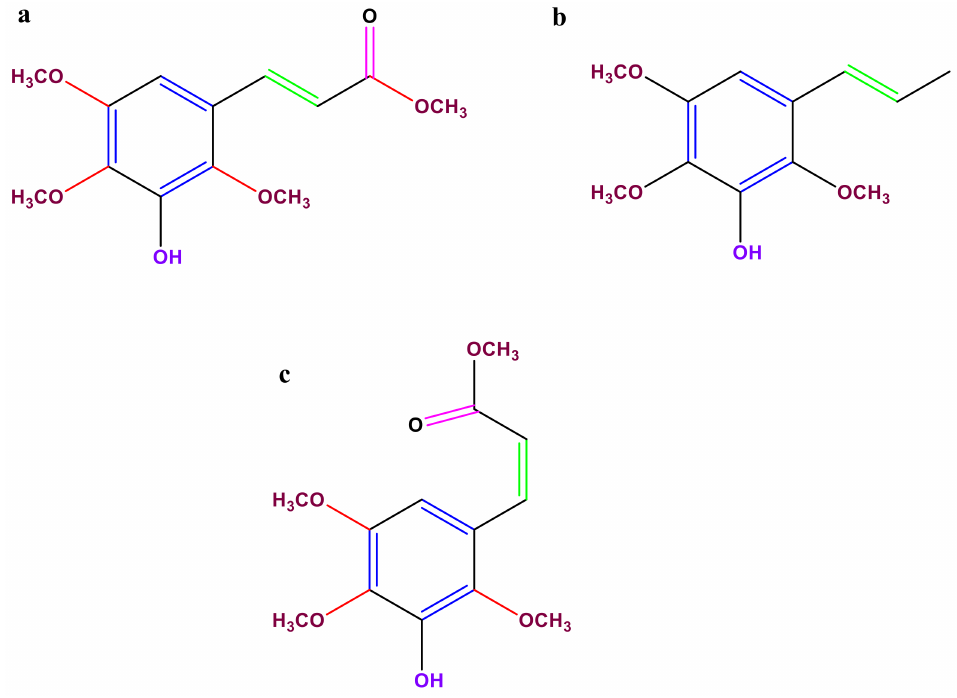
Figure 1. Chemical statures of: ( a ) Tagalphenylpropanoidins A; ( b ) tagalphenylpropanoidins B; ( c ) 2,3,6-trimethoxy-5-(1-propenyl)